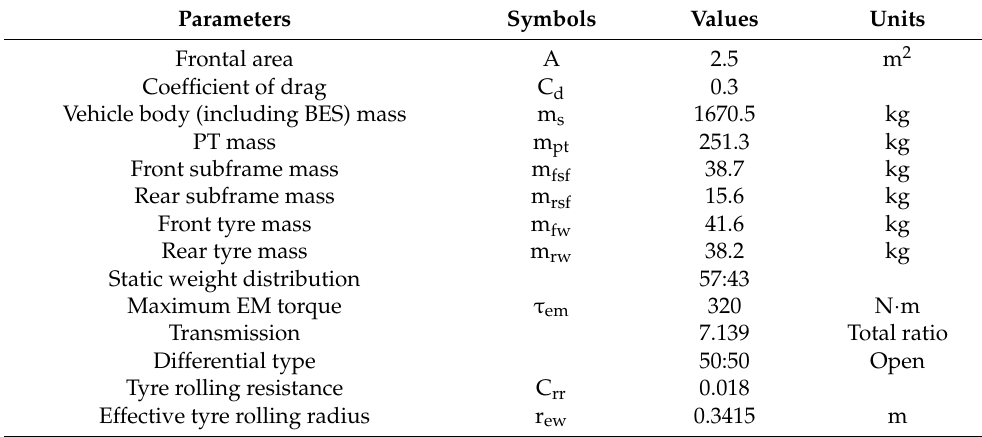
Figure 4. Longitudinal nonlinear compliance models: ( a ) front and rear subframe with bushes; ( b ) front and rear suspensions; ( c ) stiffness properties. Table 3. 2WD REEV